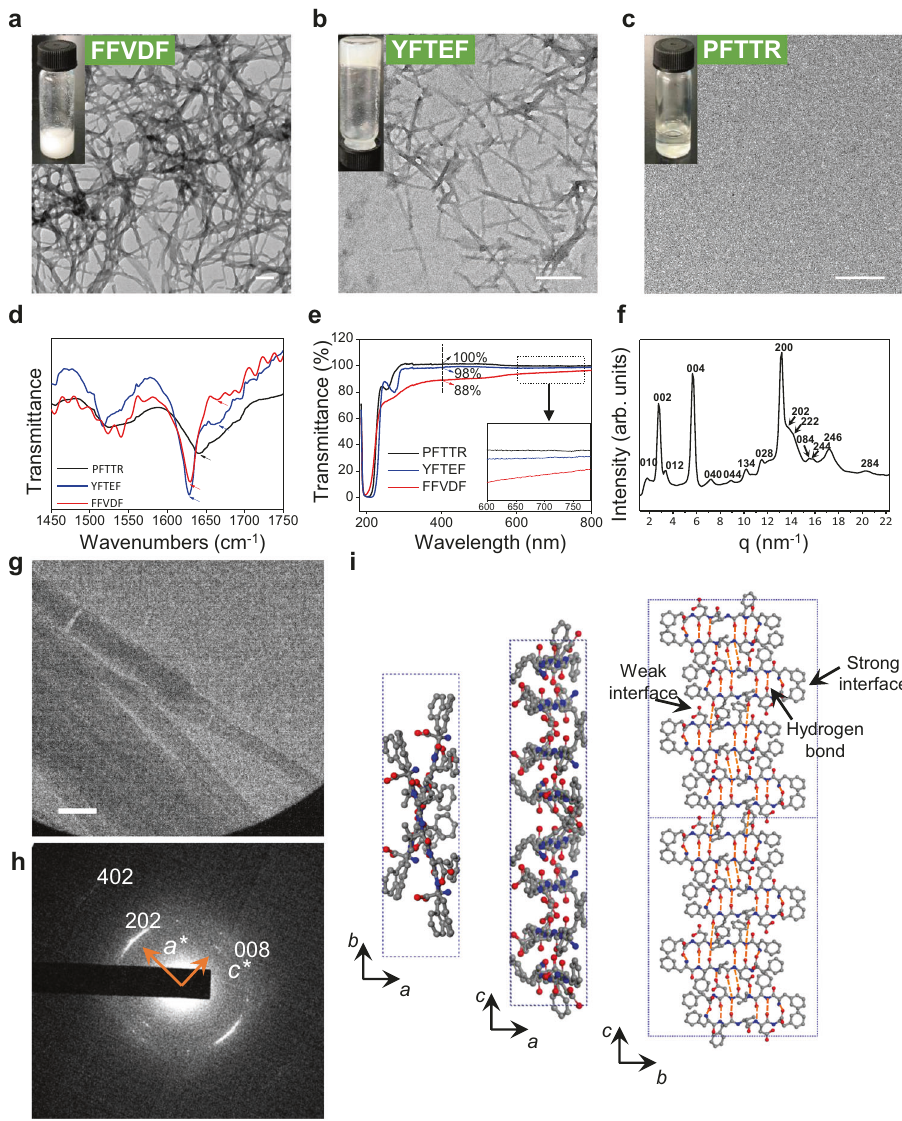
Fig. 3 Structural characterization of identi fi ed self-assembling pentapeptides. a – c TEM images of FFVDF, YFTEF, and PFTTR pentapeptides (30 mM in H 2 O). Insets: photographs of the suspension, gel, and solution. The scale bar is 200 nm. d FT-IR absorption spectra in the amide I region of pentapeptides FFVDF, YFTEF, and PFTTR (30 mM in H 2 O); narrowing and red-shifting of the amide modes of FFVDF and YFTEF indicate the presence of well-ordered assemblies for these peptides. e The transmittance spectra of FFVDF, YFTEF, and PFTTR at a concentration of 20 µ M. f X-ray diffraction powder pattern of FFVDF nano fi brils. g Bright- fi eld TEM image of nano fi brils self-assembled from FFVDF (30 μ M in H 2 O with 1% DMSO). The scale bar is 200 nm. h Selected-area electron diffraction (SAED) pattern of the nano fi bers corresponding to the part of BF image in ( g ). i ab-, ac-, bc -plane projections of